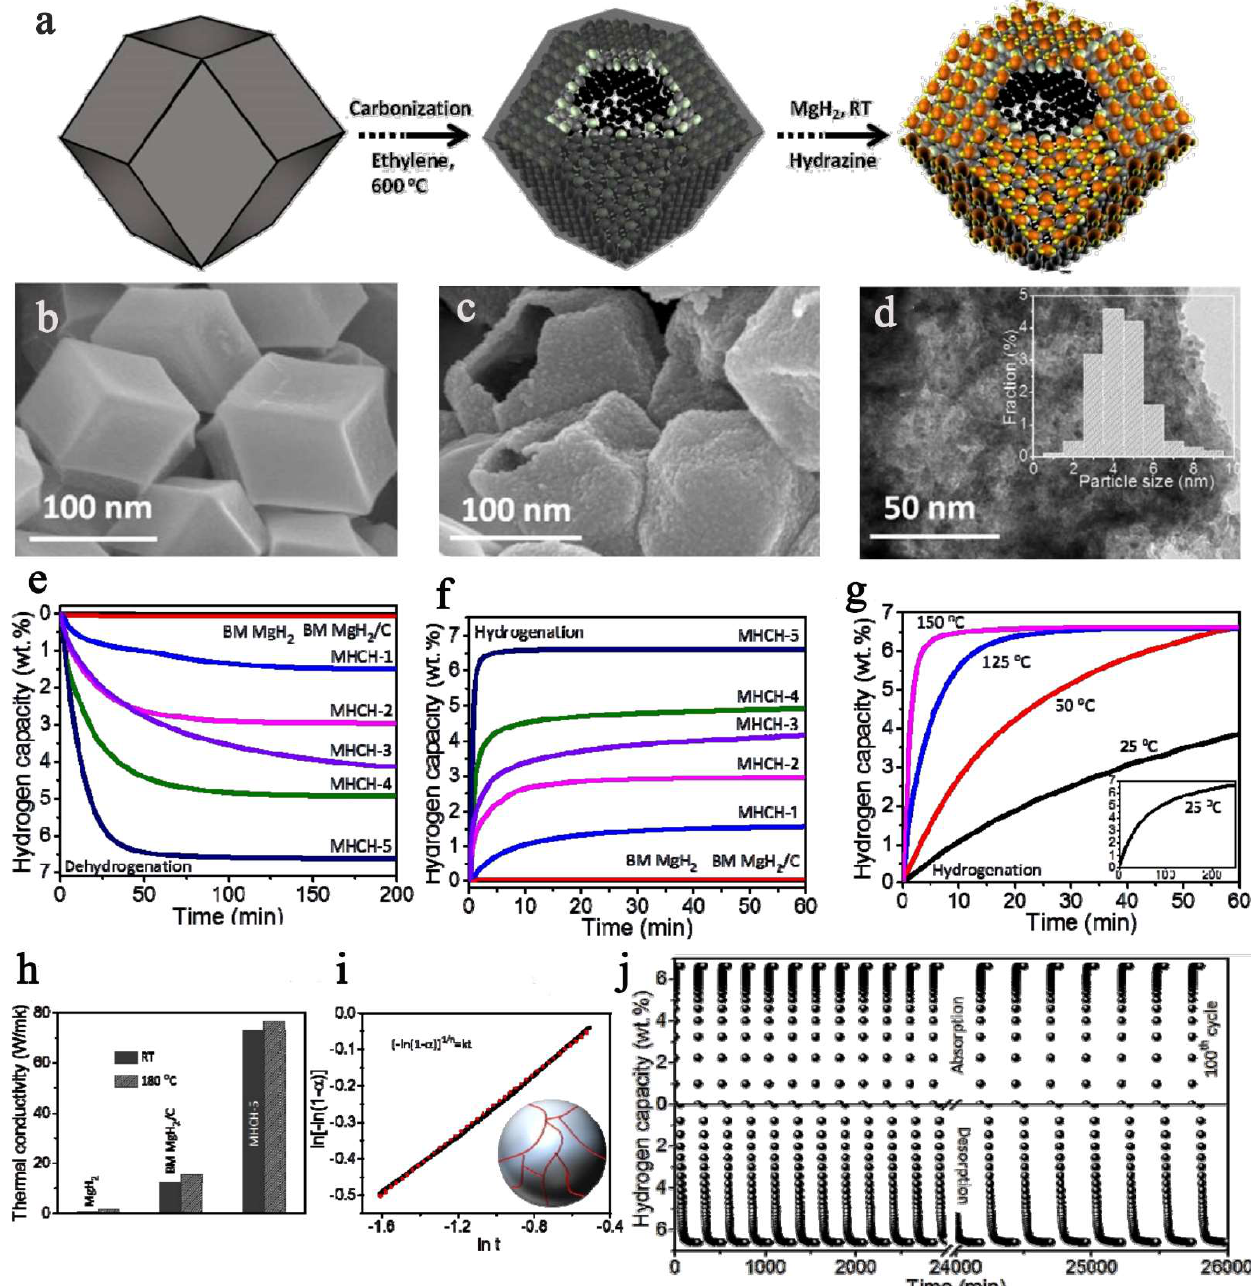
Figure 11. ( a ) Schematics displaying the self-assembled MgH 2 on three-dimensional metal interacted carbon. ( b ) SEM image of prepared metal-interacted 3-D carbon; ( c ) SEM, ( d ) TEM images of the MHCH-5; ( e ) dehydrogenation of the as-synthesized MHCH samples at 180 °C in comparison to ball-milled MgH 2 and MgH 2 /C; ( f ) Isothermal hydrogenation; ( g ) Hydrogen absorption of the MHCH-5 for different temperatures—the inset ( g ) shows the hydrogen absorption property of the MHCH-5 at 25 °C, over a long time period; hydrogenation and dehydrogenation were performed under hydrogen pressures of 10 bar and 0.01 bar, respectively; ( h ) Thermal conductivity variation in MHCH-5, MgH 2 , and ball-milled MgH 2 /C for ambient temperature and 180 °C; ( i ) The growth mechanism of MgH 2 in MHCH samples correlating with a Johnson–Mehl–Avrami model. ( j ) Reversible hydrogen (under 10 bar H 2 pressure) and dehydrogenation (under 0.01 bar H 2 pressure) performance of the MHCH-5 at 180 °C. Reprinted/adapted with permission from Ref. [137]. 2017, The Royal Society of Chemistry; RSC Pub.